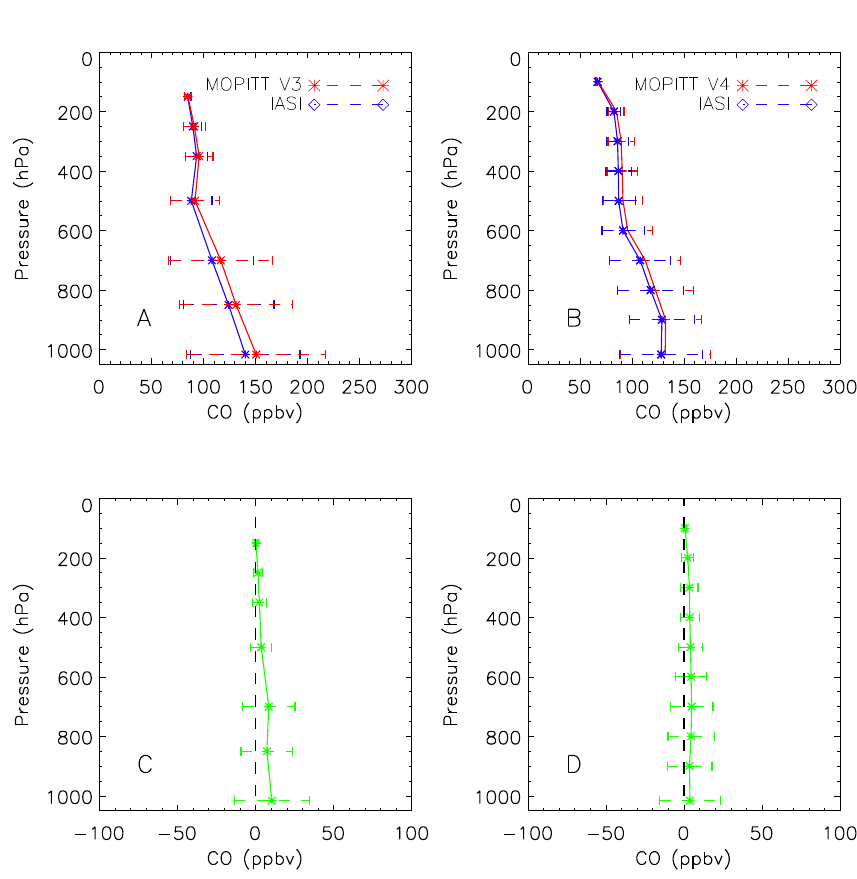
Fig. 13. Same as Fig. 12, but for x MOP and x IASI : (A) adjusted MOPITT V3 and MOPITT-smoothed IASI CO mean profiles; (B) adjusted MOPITT V4 and MOPITT-smoothed IASI CO mean profiles; (C) the mean difference between adjusted MOPITT V3 CO and MOPITT-smoothed IASI CO profiles; and (D) the mean difference between adjusted MOPITT V4 CO and MOPITT-smoothed IASI CO profiles. (A) and (B) are in relation to the retrieval of a true profile, as provided by GEOS-Chem. All comparisons are for over the ocean and during the daytime of 1 September 2007, over the Southern Africa region.